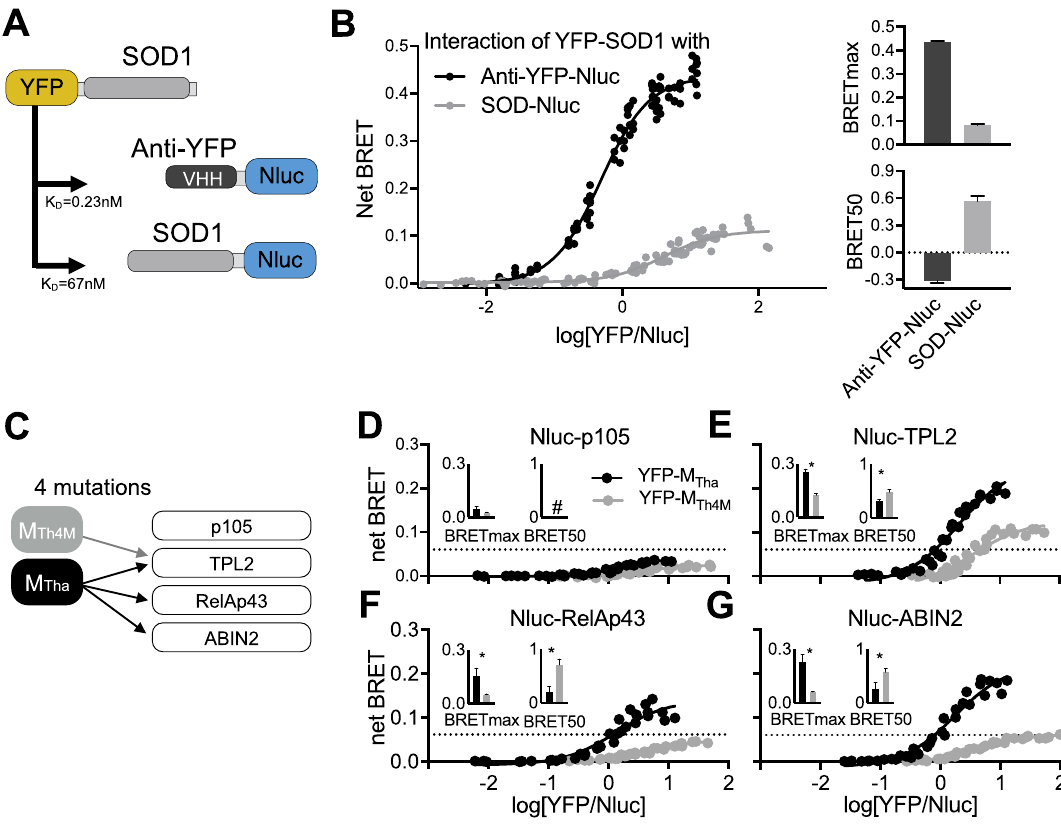
Figure 2. Variable donor BRET saturation assay applied to study protein complex with distinctive affinities. ( A ) Known interaction parameters of YFP and anti-YFP nanobody or SOD1 dimers. ( B ) Variable donor BRET saturation assay of donor SOD-Nluc or anti-YFP-Nluc with acceptor YFP-SOD1. The net BRET was plotted with the YFP/Nluc expression ratios to determine both BRETmax and BRET50. ( C ) Rabies virus M Tha and M Th4M mutant proteins interact differentially with host proteins p105, TPL2, RelAp43, and ABIN2. ( D – G ) Variable donor BRET saturation assay of donor Nluc-p105 ( D ), -TPL2 ( E ), -RelAp43 ( F ) or -ABIN2 ( G ) and acceptor (YFP-M Tha or M Th4M ) as in Fig. 1 and both BRETmax and BRET50 were plotted. A 3σ-threshold (0.06) was defined, based on the M-p105 interactions considered as negative controls. # not displayed. Unpaired, parametric two-tailed t test were performed with GraphPad (Prism), *p < nanobody (BRET50 = − 0.3) compared to SOD1 homodimers (BRET50 = 0.6). The association of all dimers at a A:D ratio of 1:1, representing the minimum BRET50 theoretically possible, suggests that BRET saturation assays